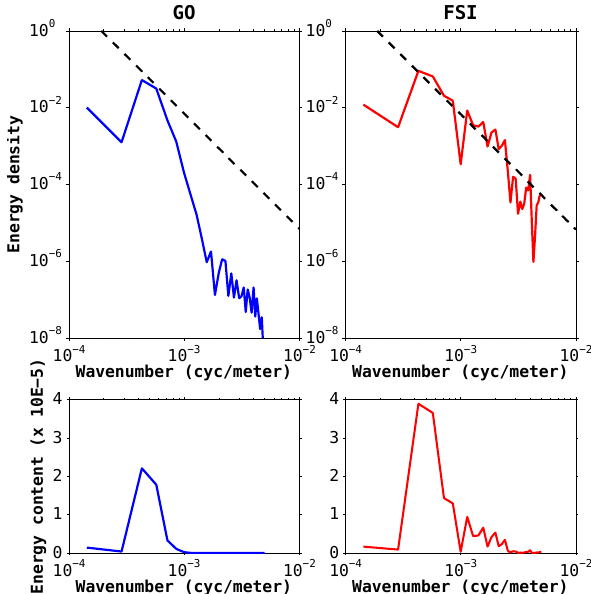
Figure 3. Vertical wavenumber spectra of the normalized temper- ature T (cid:48) /T 0 profiles shown in Fig. 2 at 20–27km height range. A model spectrum of saturated gravity waves from Eq. (1) is plotted as a dashed line. Bottom panels show an area-preserving form of the